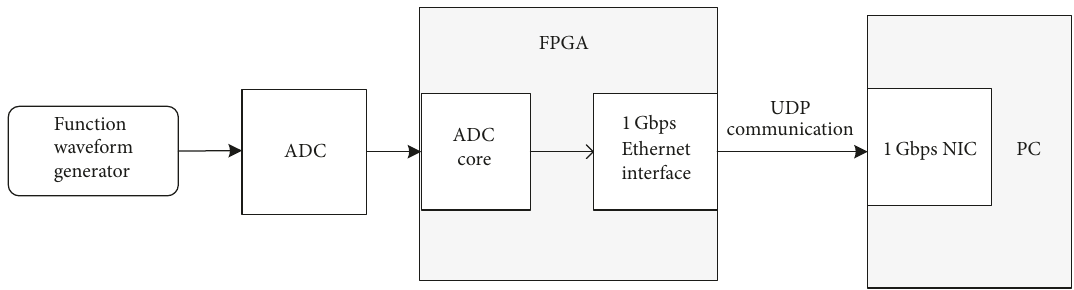
Figure 19: Experimental setup for a streaming core using FMC150 ADC core and Gbe